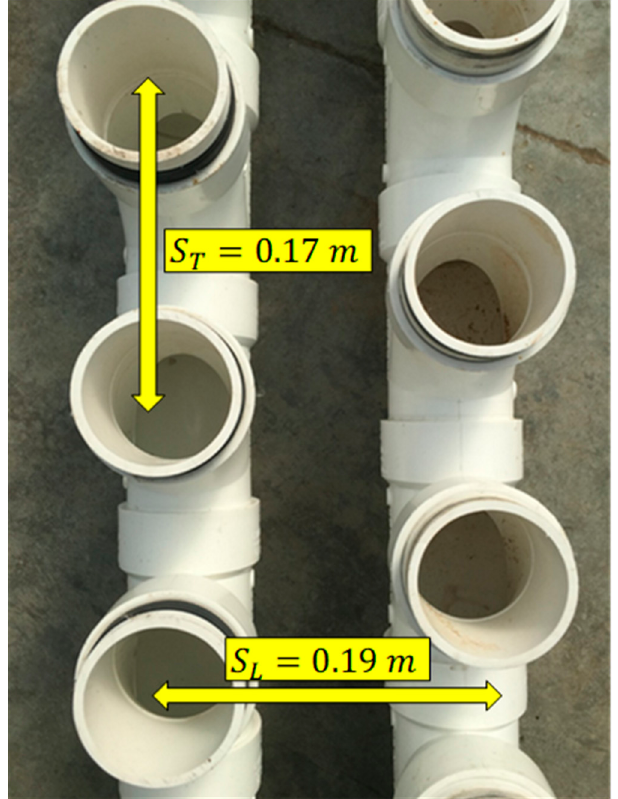
Figure 6. Top down view of the manifold of the cyclic flow PBR tube bank. S T and S L are measured factors used in determining the forced convection heat transfer coefficient of a staggered tube bank heat exchanger.